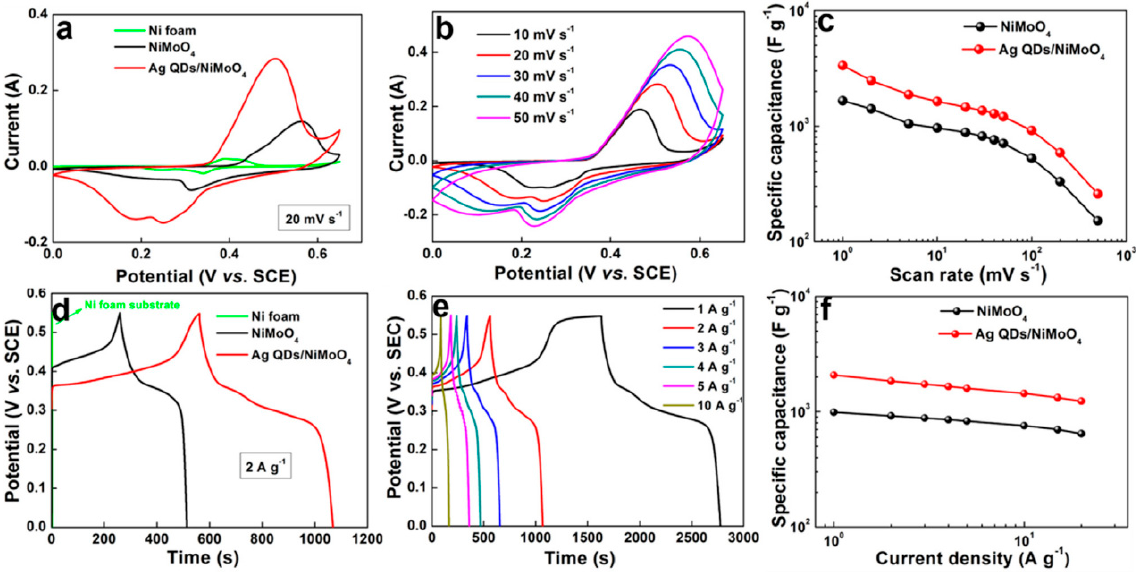
Figure 11. CV and GCD measurements for the NiMoO 4 and Ag QDs/NiMoO 4 electrodes in the three ‐ electrode system: ( a ) contrastive CV curves at 20 mV s − 1 ; ( b ) CV curves of Ag QDs/NiMoO 4 electrode; ( c ) specific capacitances as a function of scan rates; ( d ) contrastive GCD curves at 2 A g − 1 ; ( e ) rate performances of Ag QDs/NiMoO 4 electrode; and ( f ) specific capacitances as a function of current densities. Reproduced with permission from [192]. Copyright 2020 Elsevier. Table 2. The performance of electrodes based on binary and ternary